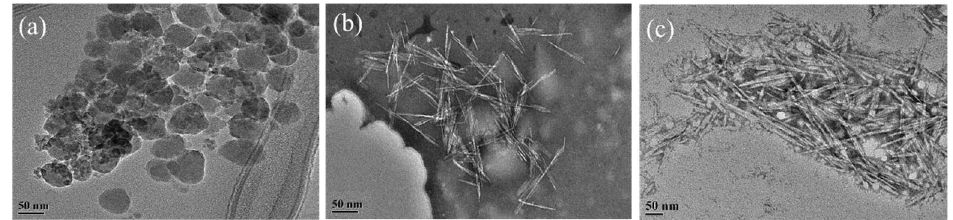
Figure 1. The morphology of ZnO-overlaid cellulose nanocrystals (CNCs) made from ZnO nanoparticles and CNCs: ( a ) ZnO, ( b ) CNCs, and ( c ) CNCs-ZnO.